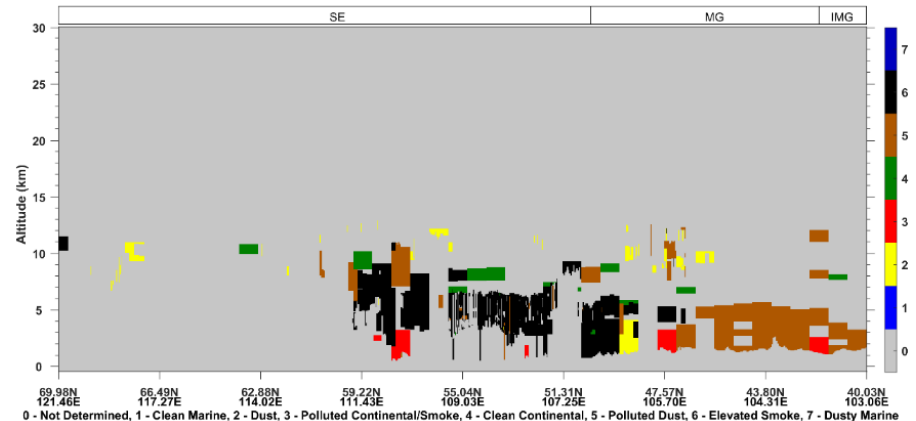
Figure 3. 25 June 2017: CALIOP-derived vertical profile of the vertical feature mask of aerosol over the ground track (solid blue line) shown in Figure 1. CALIOP successively overpassed Siberia (SE), Mongolia (MG), and Inner Mongolia Autonomous Region of China (IMG).